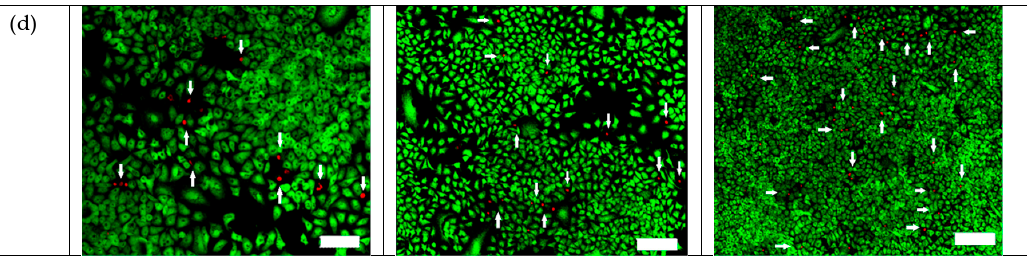
Figure 5. The PDT efficacy of TiO 2 :C exposed to X-ray irradiation, evaluated by live/dead staining of ( a ) control group; ( b ) X-ray-treated group; ( c ) TiO 2 :C-treated group; and ( d ) TiO 2 :C-X-ray group (scale bars: 200 μ m), where green represents living cells and red represents dead cells.